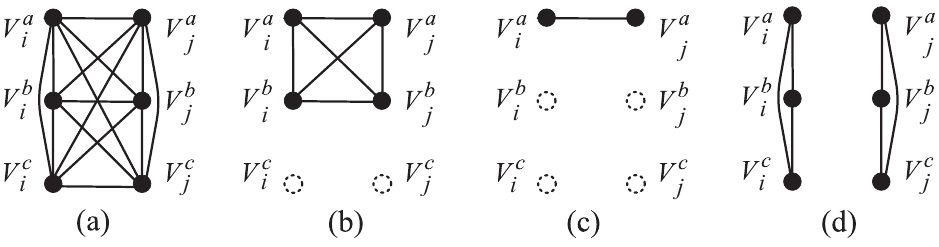
Fig. 2. Subgraphs corresponding to phase voltages of two adjacent buses. Figure 4. Sub-figures ( a – c ) present two adjacent three-, two-, and single-phase buses that are connected via a distribution line. Sub-figure ( d ) presents two adjacent three-phase buses that are connected via an ideal transformer [64].